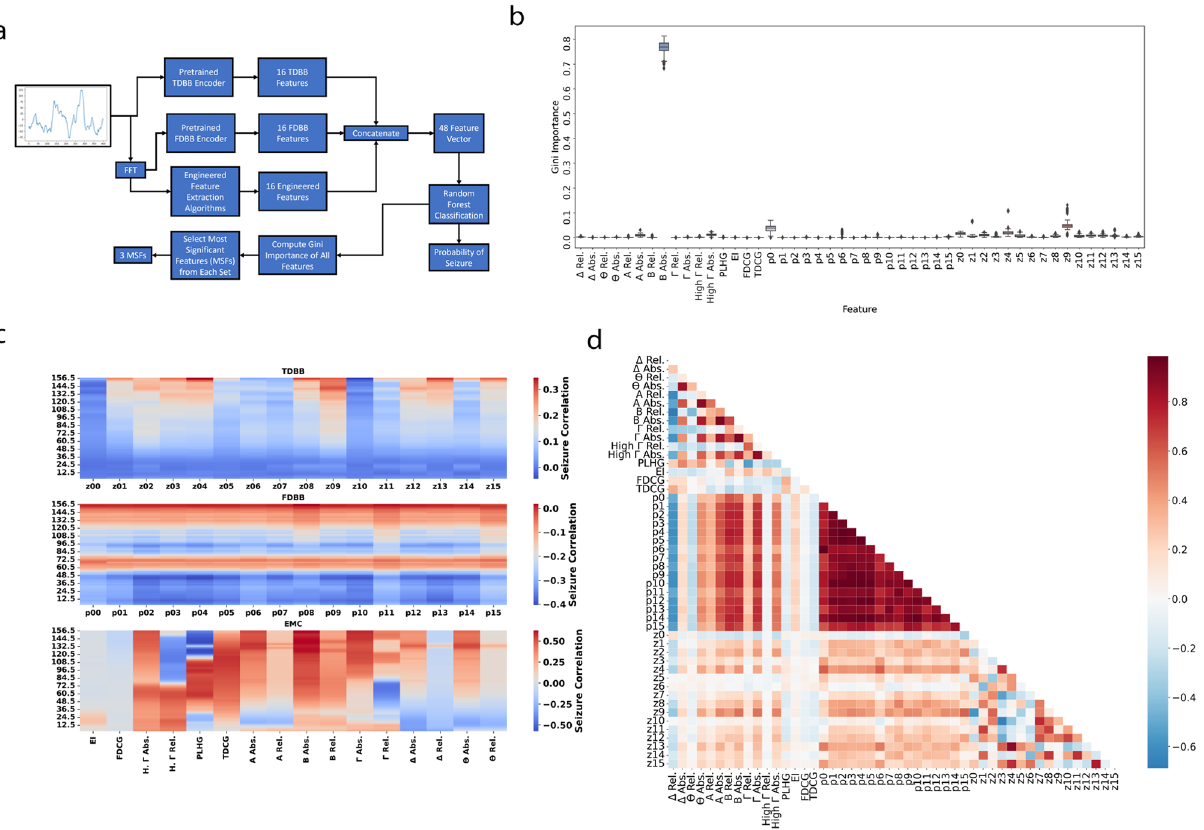
Figure 2. Process for identifying and interpreting significant features during pretraining using random forest. ( a ) Process using Random Forest Classifiers (RFCs) to identify the most significant features (MSFs). ( b ) Relative Gini Importance of all features. ( c ) Frequency response of encoded feature spaces. ( d ) Correlation between feature